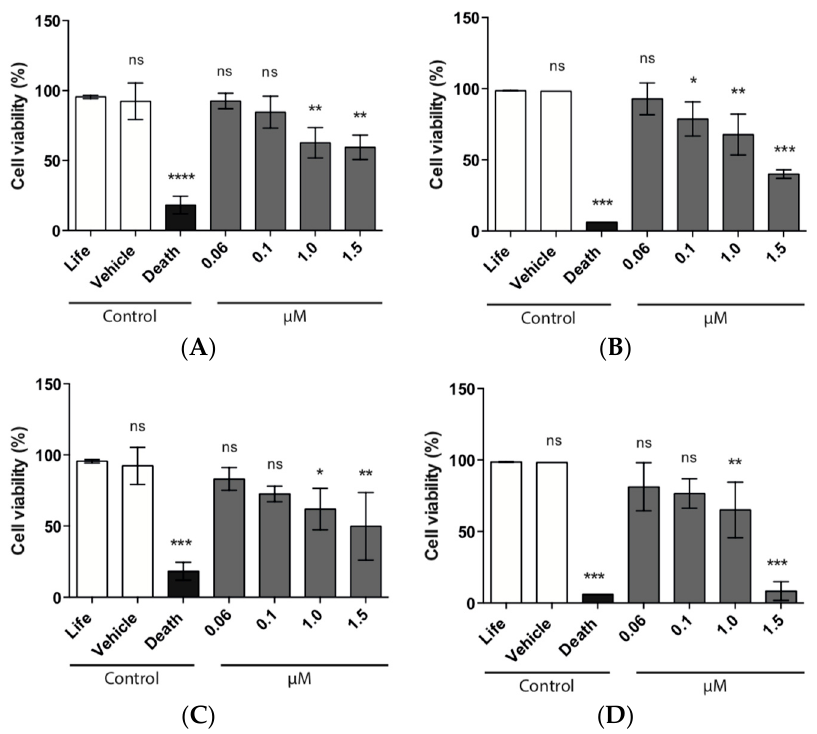
Figure 7. Viability expressed as cell viability percentage of HeLa cells treated with different concentrations of EE/alginate nanoparticles compared to the Culture medium control. A: TC 30 CR 0.5/ 1 h; B: TC 30 CR 0.5/ 24 h; C: TC 30 CR 1.33/ 1 h; and D: TC 30 CR 1.33/ 24 h.* = P < 0.1, ** = P < 0.01, *** = P < 0.001, ns = no statistically significant difference.